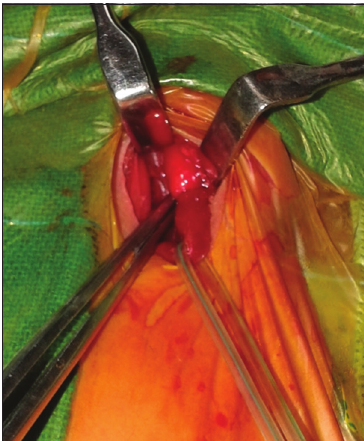
Figure 1: The blind-ending upper esophageal pouch and the upper end of lower esophageal pouch seen adjacent to each other through the cervical incision